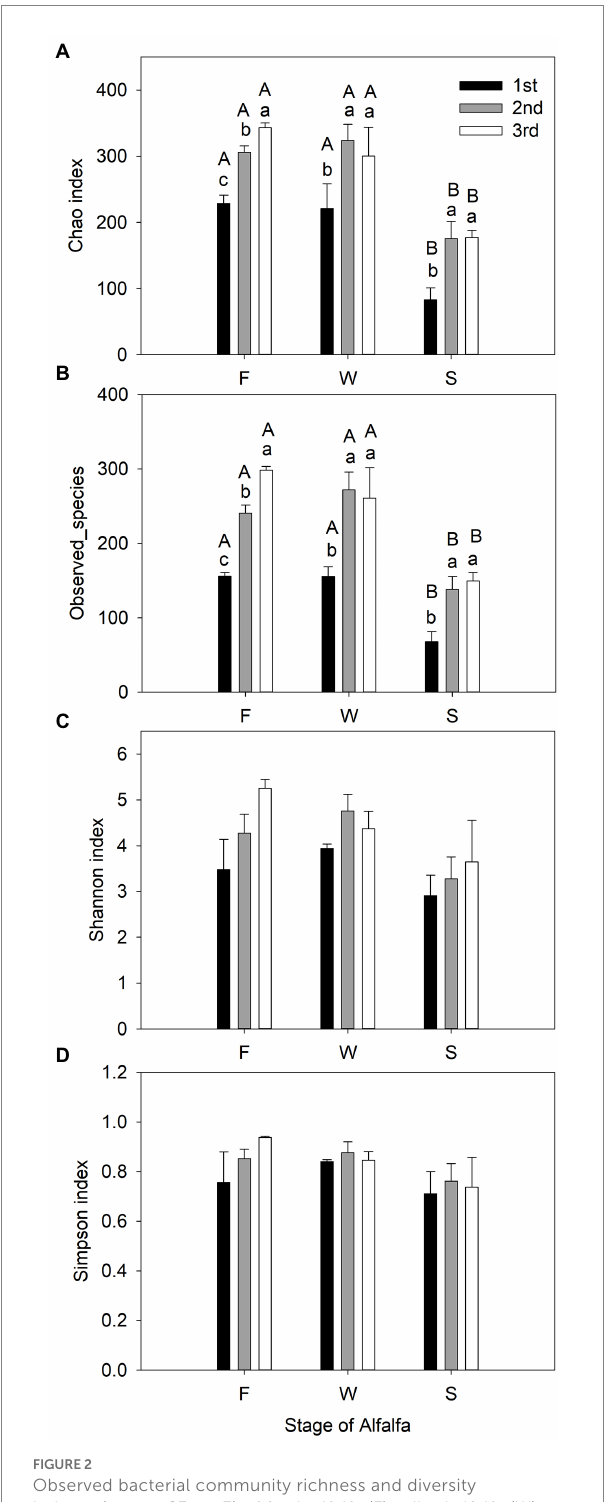
FIGURE 2 Observed bacterial community richness and diversity indexes (mean ± SE, n = 3) of fresh alfalfa (F), wilted alfalfa (W), and ensiled alfalfa (S). (A) Estimate of Richness Chao1 index. (B) Estimate of Richness Observed_species. (C) Estimate of diversity Shannon index. (D) Estimate of diversity Simpson index. The black filled bar indicate the first cutting alfalfa, the gray filled bar indicted the second cutting alfalfa, and the non- filled bar indicate the third cutting alfalfa. Bar with different capital letters differ among F, W, and S in the same cutting; Bar with different lowercase letters differ among different cuttings.